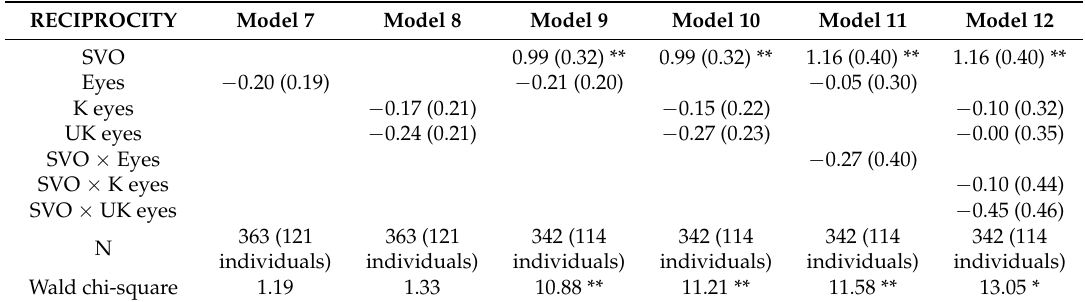
Table 2. Logistic regression estimates of the impact of SVO, kind eyes (K eyes) and unkind eyes (UK eyes), on